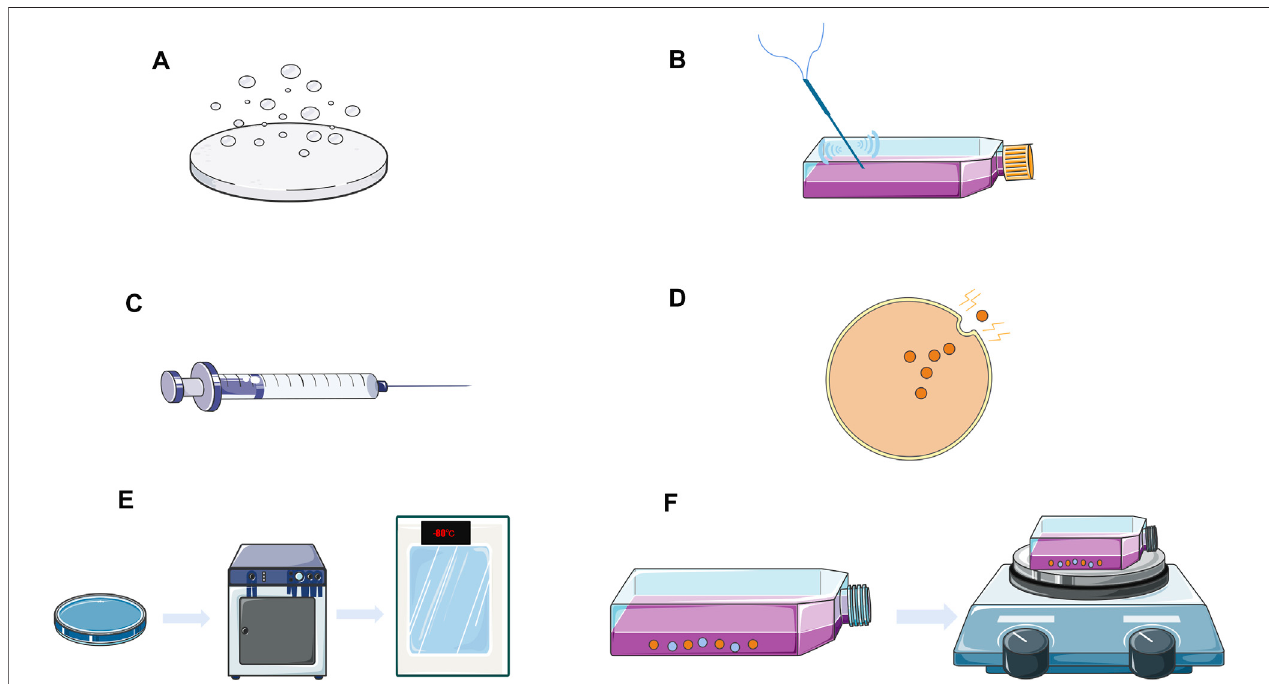
FIGURE2| Exosomes extracellulardrugdeliverystrategy. (A) Drugco-incubation; (B) Acoustic processing; (C) Squeezemethod; (D) Electroporation; (E) Freeze- thaw; (F) Saponin-assisted loading